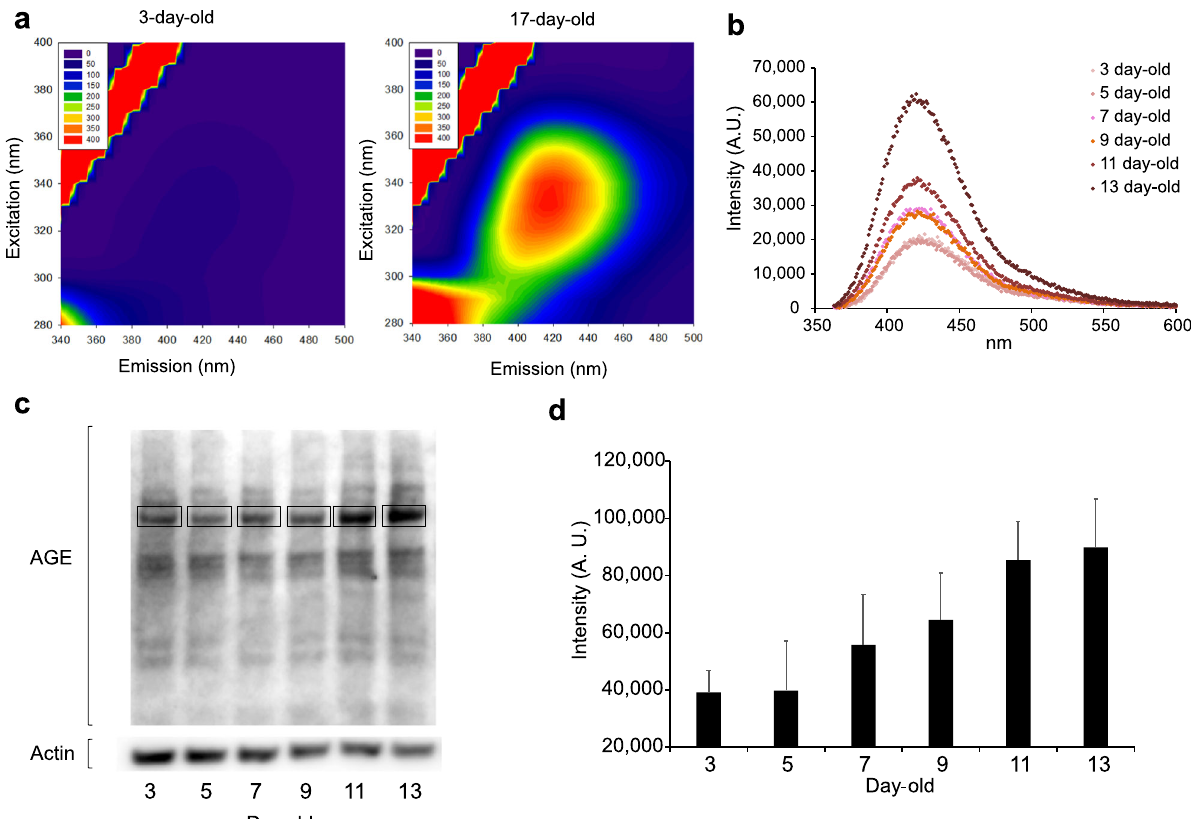
Fig. 1 Fluorescence spectrophotometry and the AGEs of worm protein samples. a Excitation emission matrix (EEM) plots of auto fl uorescence from lysed worms at 3-day old and 17-day olds. The fl uorescence levels at the emission wavelength in the EEM plots are displayed as colored heatmaps. One hundred worms (wild-type N2) each of 3-day-old and 17-day-old were lysed in 3 µL of lysis buffer and 4 µL of 15% SDS. Proteins were released by freeze-thaw cycles, and the photoluminescent spectra were collected with a fl uorescence spectrophotometer (Hitachi FL-4500). Fluorescence properties of lysed nematodes were analyzed using EEM fl uorescence spectroscopy. Excitation at 325 – 365 nm made 17-day-old worms fl uoresce with the highest emissions in the 400 – 430 nm interval corresponding trajectories as a series of fl uorescence intensities, whereas 3-day-old young worms did not fl uoresce. Multivariate analysis (single-wavelength excitation with multiple-wavelength emission, and synchronous-scanning fl uorometry) yielded EEM plots consisting of single-scan excitation. b Levels of auto fl uorescence (ex 340/em 360 – 600) by worm protein samples extracted from animals of each age group (3 – 13 days old). Worms (wild-type N2) were collected in tubes, washed fi ve times, and lysed in each tube. Samples were then ground using a Mini Cordless Grinder (Funakoshi, Tokyo, Japan) to release protein. Protein contents were quantitatively measured as described in the Methods. A fl uorescence spectrum was determined for each 30-µL sample (containing 1.5 μ g of total protein) using a multimode grating microplate reader model SH-9000Lab (Corona Electric, Ibaraki, Japan). Each measurement was carried out three times. c Western blotting analysis of the AGE CML in samples extracted from worm (wild-type N2) populations of different ages. A representative photograph of three reproducible experiments is shown. Blots derived from different parts of the same gel (shown in Supplementary Fig. 1) and were processed in parallel. d Quanti fi cation of AGEs in western blots using densitometry. The bands surrounded by rectangular frames in Fig. 1c were quanti fi ed, and data from three reproducible experiments is shown as mean ±